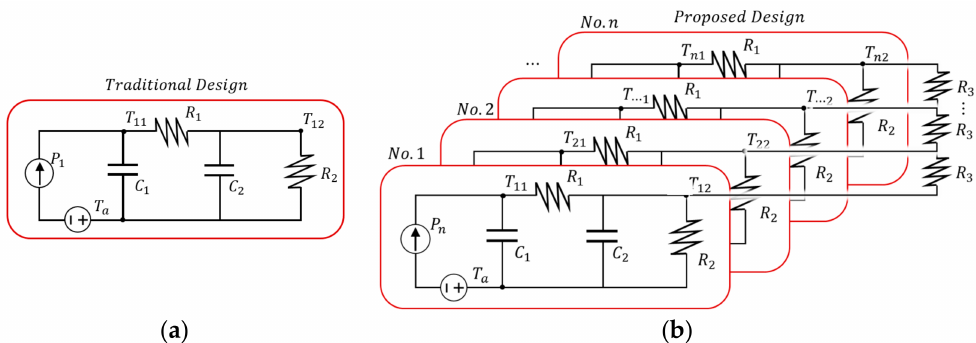
Figure 5. ( a ) Simplified thermal equivalent circuit of a normal actuator module; ( b ) Simplified thermal equivalent circuit of the n -CoSMo